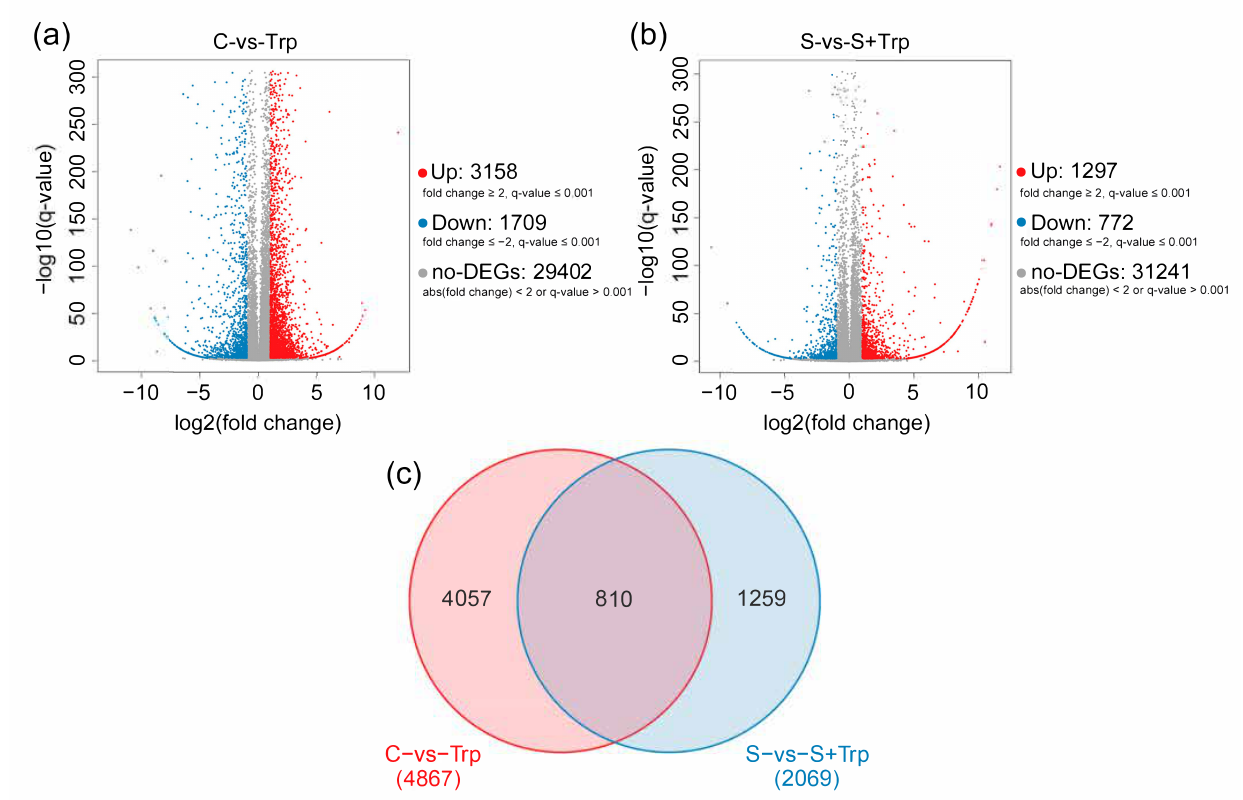
Figure 2. Volcano plot ( a , b ) and Venn diagram ( c ) of DEGs in the C-vs-Trp group and S-vs-S+Trp group.